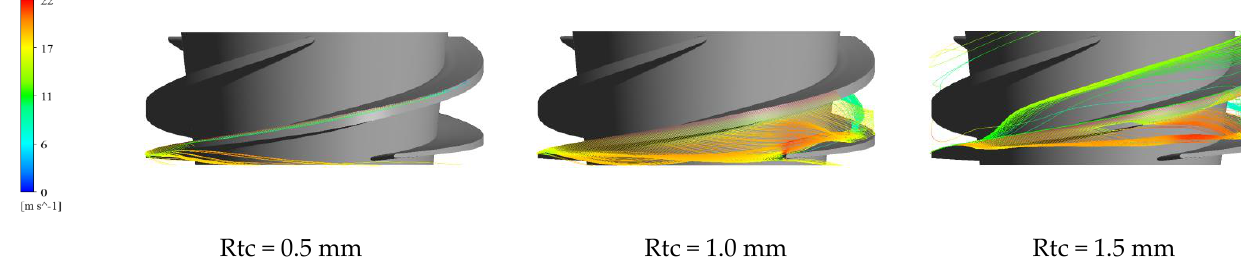
Figure 14. Gas streamlines near impeller blade tip.